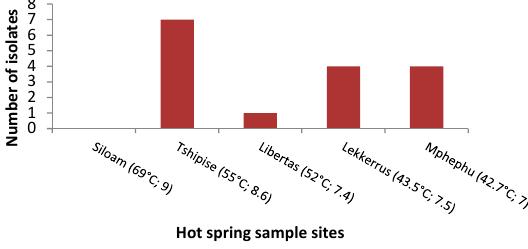
Figure 1. Distribution of the number of isolates from five hot springs, Limpopo Province, South Africa. Temperature and pH of water samples are given in parentheses.